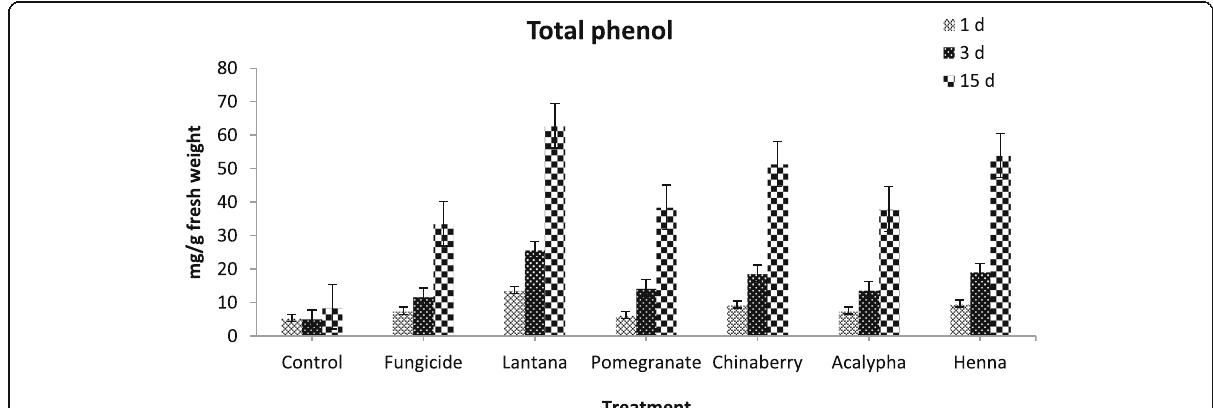
Fig. 2 Effect of some plant extracts on the total phenolic contents of wheat leaves cv. “ Gemmeiza-7 ” infected with Puccinia triticina , as compared to the fungicide Fungshow (diniconazole)